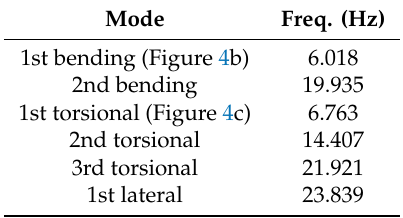
Figure 4. ( a ) Boundary conditions of the FE model of the vehicle, ( b ) mesh convergence study, ( c ) 1st bending mode (6.018 Hz) and ( d ) 1st torsional mode (6.763 Hz) of the vehicle. Table 2. Comparison of resonant frequencies for various modes of the